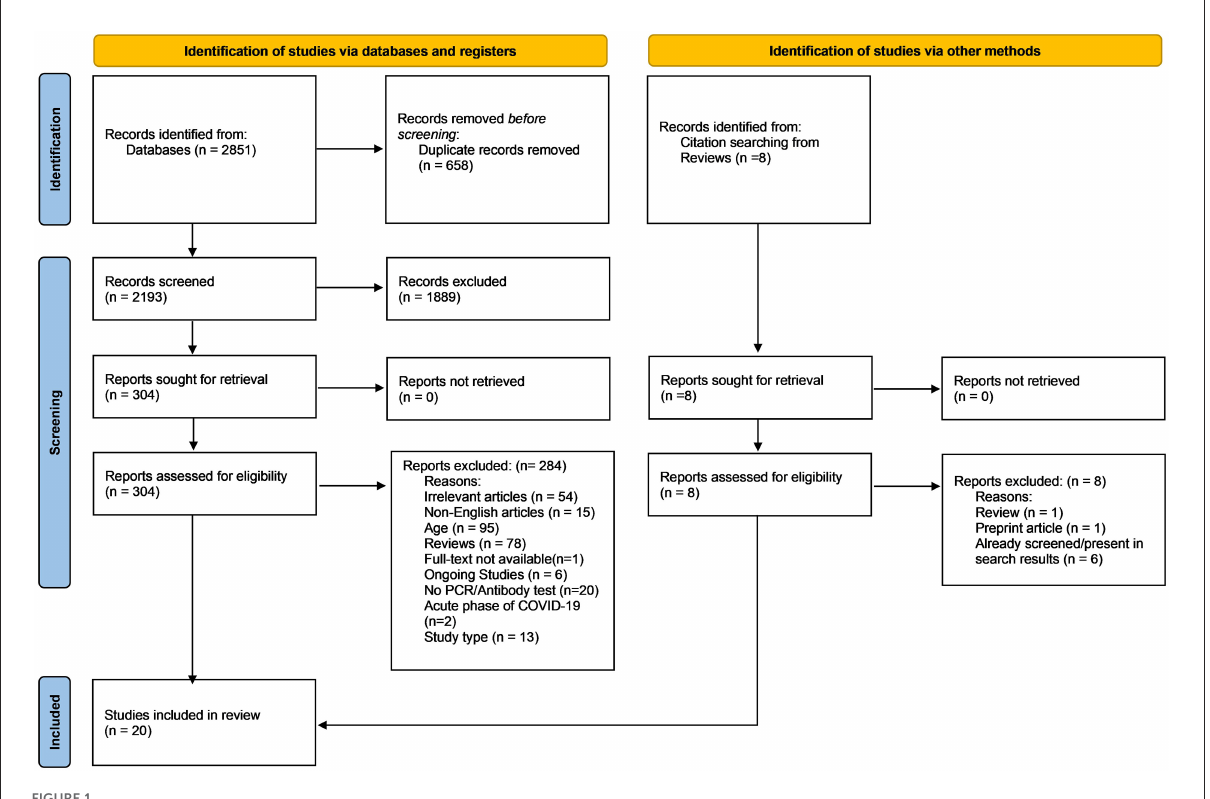
FIGURE1 Prisma flow